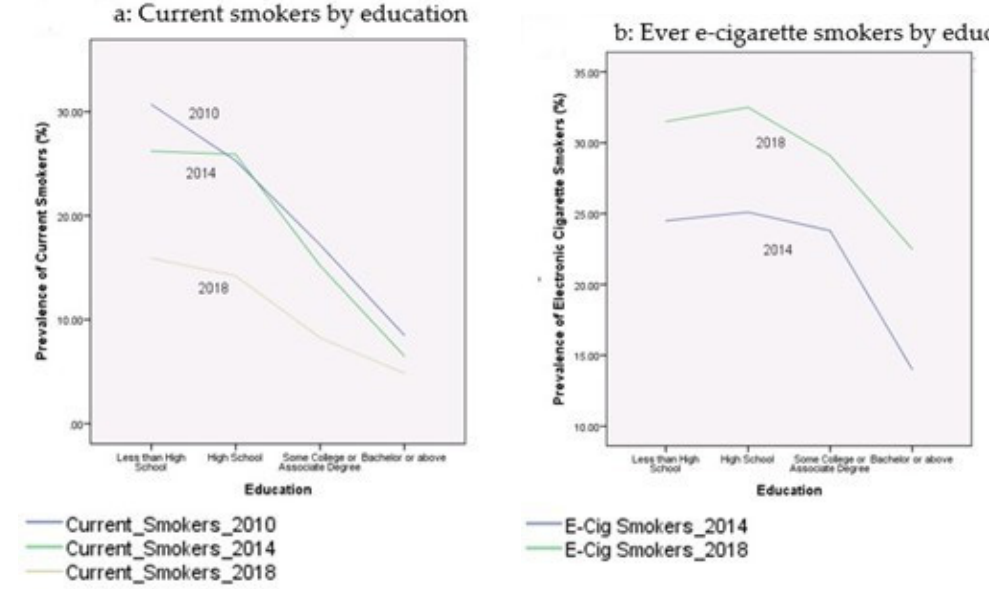
Figure 3. Prevalence of smoking behaviors by education, NHIS 2010–2018.